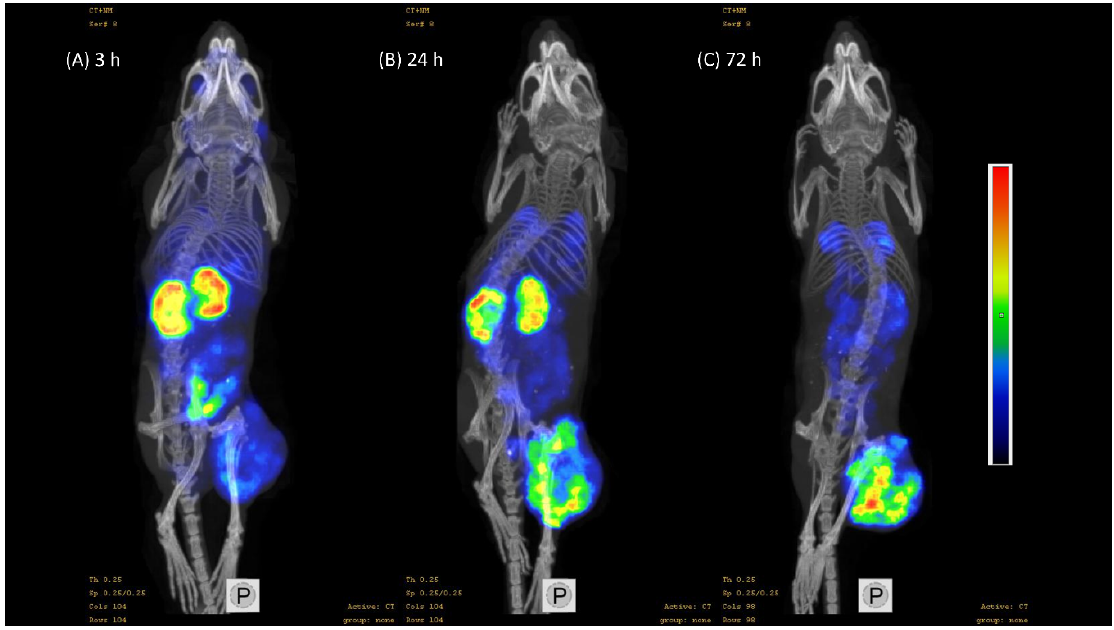
Figure 8. MicroSPECT-CT imaging of [ 125 I]I-BO530 at 3 ( A ), 24 ( B ), and 72 h pi ( C ). Balb/c nu/nu mice with PC-3pip (GRPR and PSMA positive) xenografts were injected with 40 pmol (500 KBq) of labeled heterodimer.